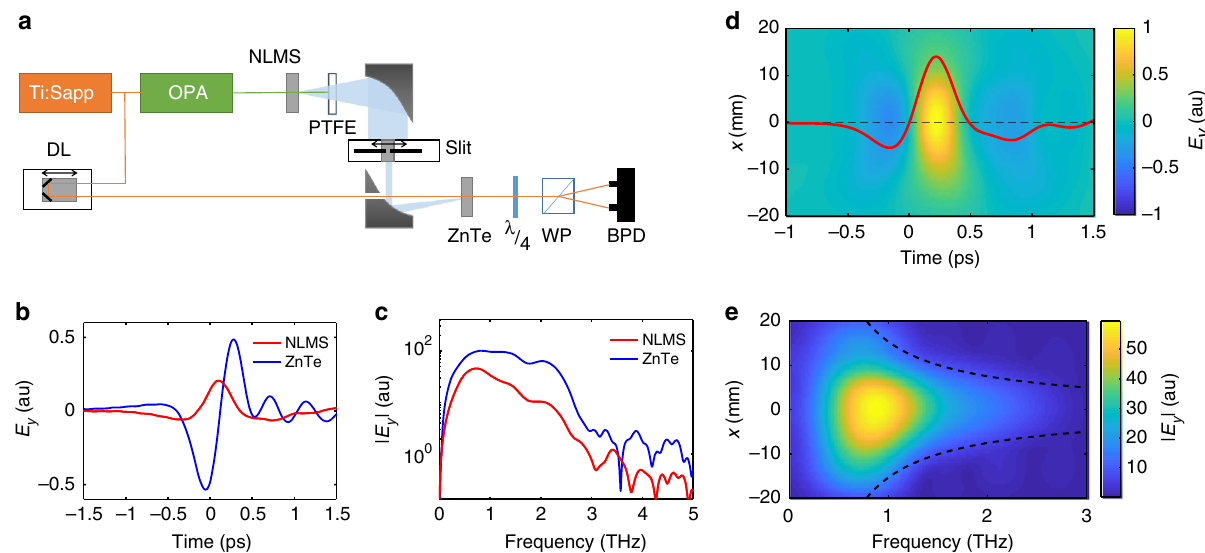
Fig. 2 Terahertz emission from uniform nonlinear metasurfaces (NLMS). a Experimental set-up. Ti:Sapp ampli fi ed titanium sapphire laser, OPA optical parametric ampli fi er, PTFE te fl on fi lter, DL delay line. ZnTe 0.5 mm ZnTe (110-cut) crystal, λ /4 quarter wave plate, WP Wollaston prism, BPD balanced photodiode. b Time domain spectroscopy (TDS) signal of terahertz (THz) pulse emitted from an NLMS (red line) and from a 0.1 mm ZnTe (110-cut) crystal under the same excitation conditions (blue line). The ripples following the single-cycle pulse emitted from the ZnTe are due to phonon absorption in the ZnTe crystal. c Emission spectrum from a uniform NLMS and ZnTe. d Spatiotemporal measurement of THz pulse emitted from NLMS, plotted in the time domain. The temporal cross-section at the center of the beam is shown in red. e Frequency domain representation of the measurement in d . The dashed